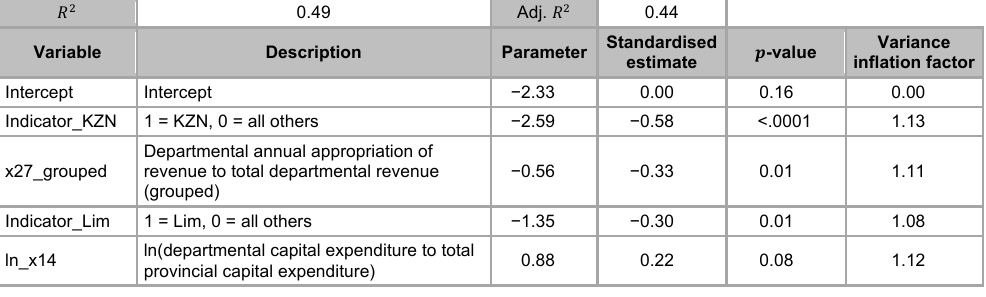
Stepwise and forward regression of the H data set